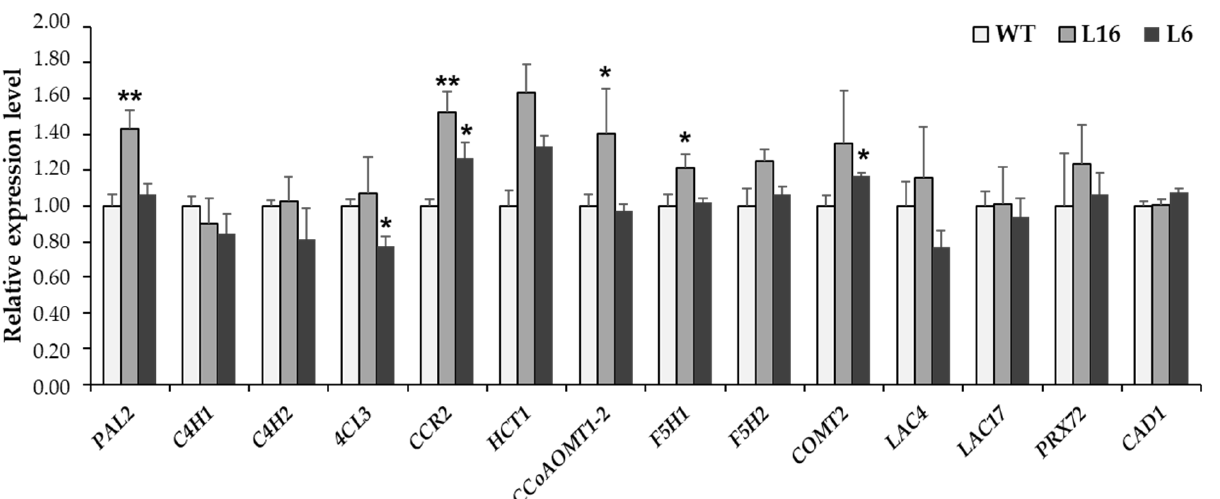
Figure 5. Relative expression level of poplar genes involved in lignin biosynthesis and polymerization in the xylem of stems of three-month-old ugt72b37 mutant (L16 and L6) and WT lines cultivated in soil, as assessed by RT-qPCR. The expression level of each gene in each sample was normalized using two reference genes, CDC2 and CYC063 . The expression level of each gene in the WT was defined as the reference level, with a relative value = 1. Values are means of four biological replicates ( ± SE). *: significant difference ( p < 0.05) compared with the WT, **: significant difference ( p < 0.01) compared with the WT ( t